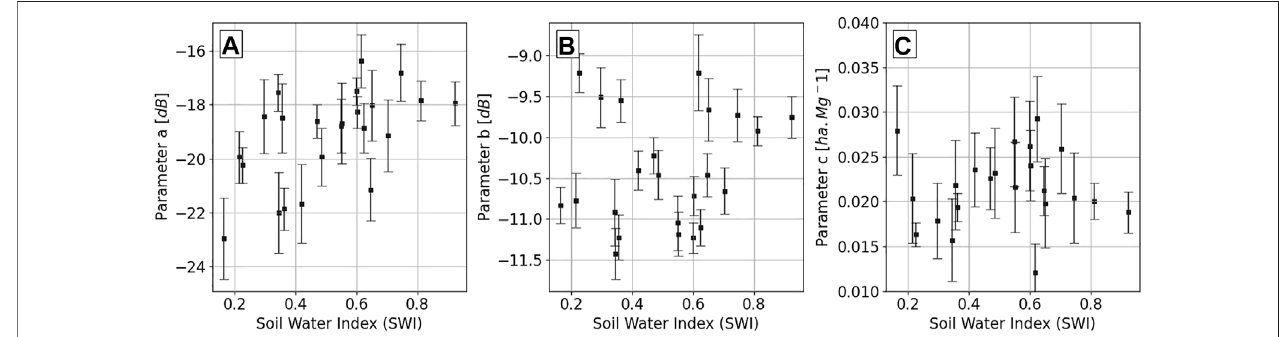
FIGURE 8 | The estimated WCM model parameters (A – C) plotted against the soil water index (SWI) derived from the Metop ASCAT sensor. The parameter a shows a positive correlation with SWI while no such trend is observed for parameters (B,C) .